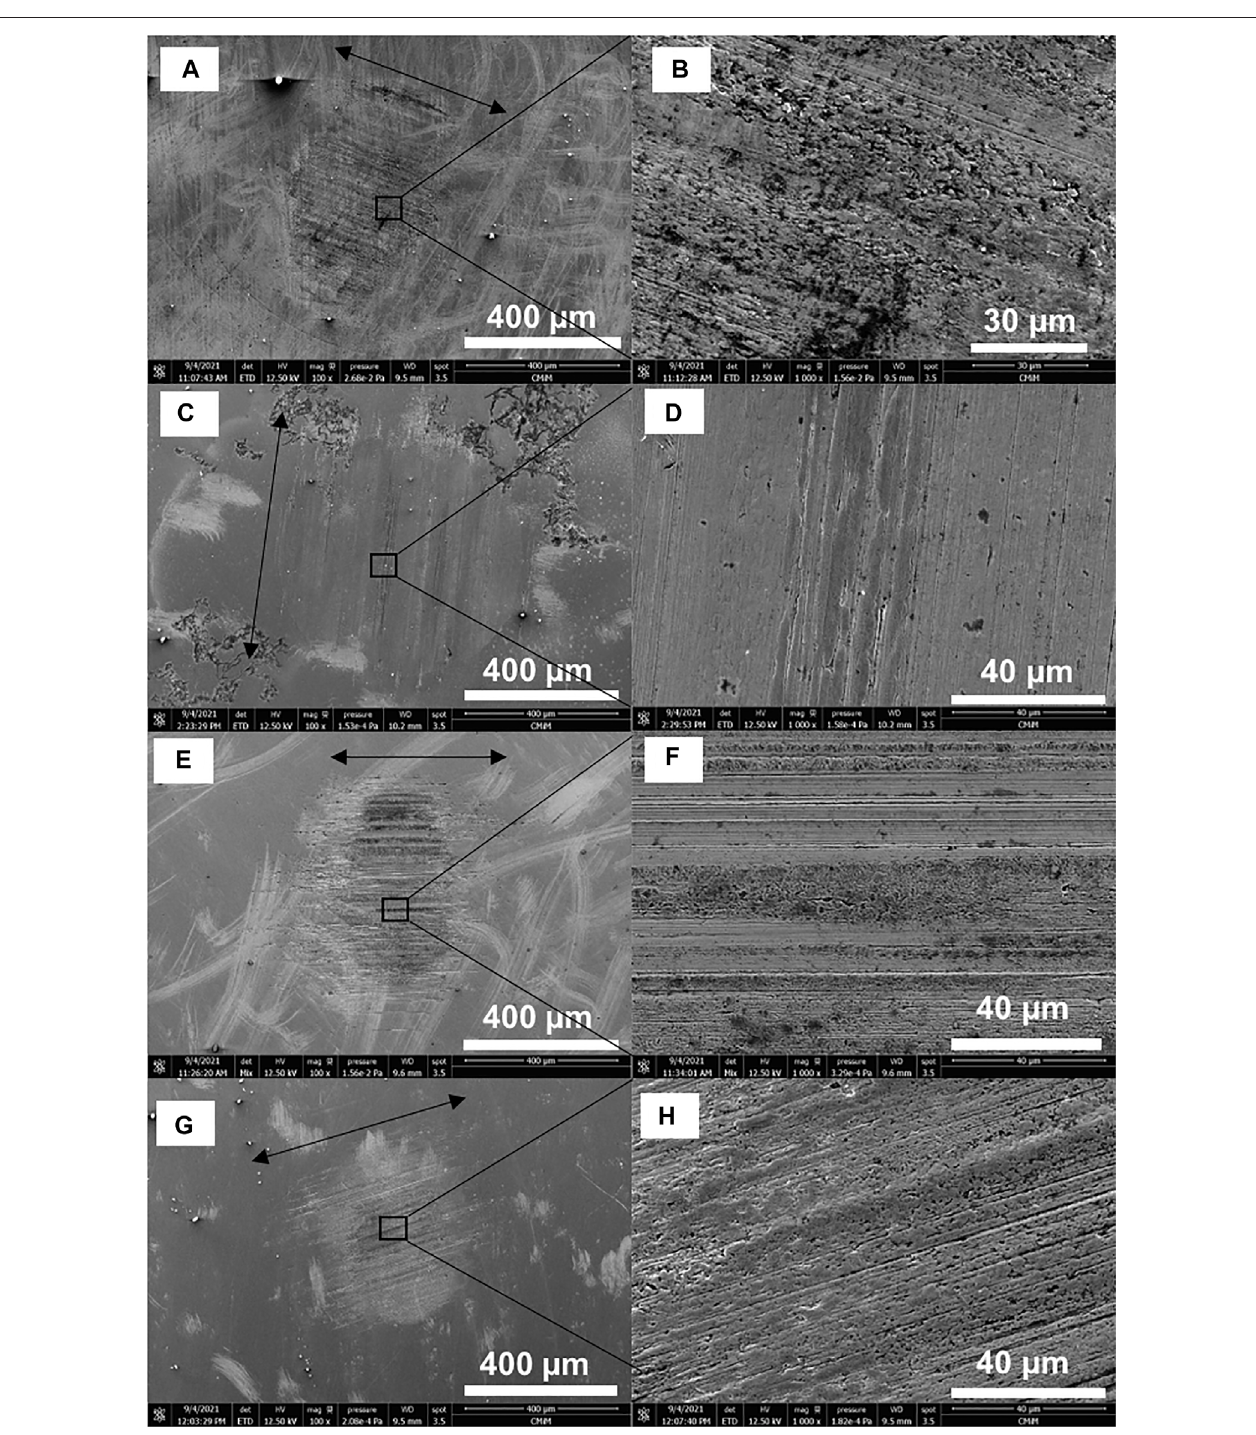
FIGURE 9 | Worn scar of the pin; lubricated by L1 (A) and (B) , L2 (C) and (D) , L3 (E) and (F) , and L4 (G) and (H) , arrow indicating the sliding direction.